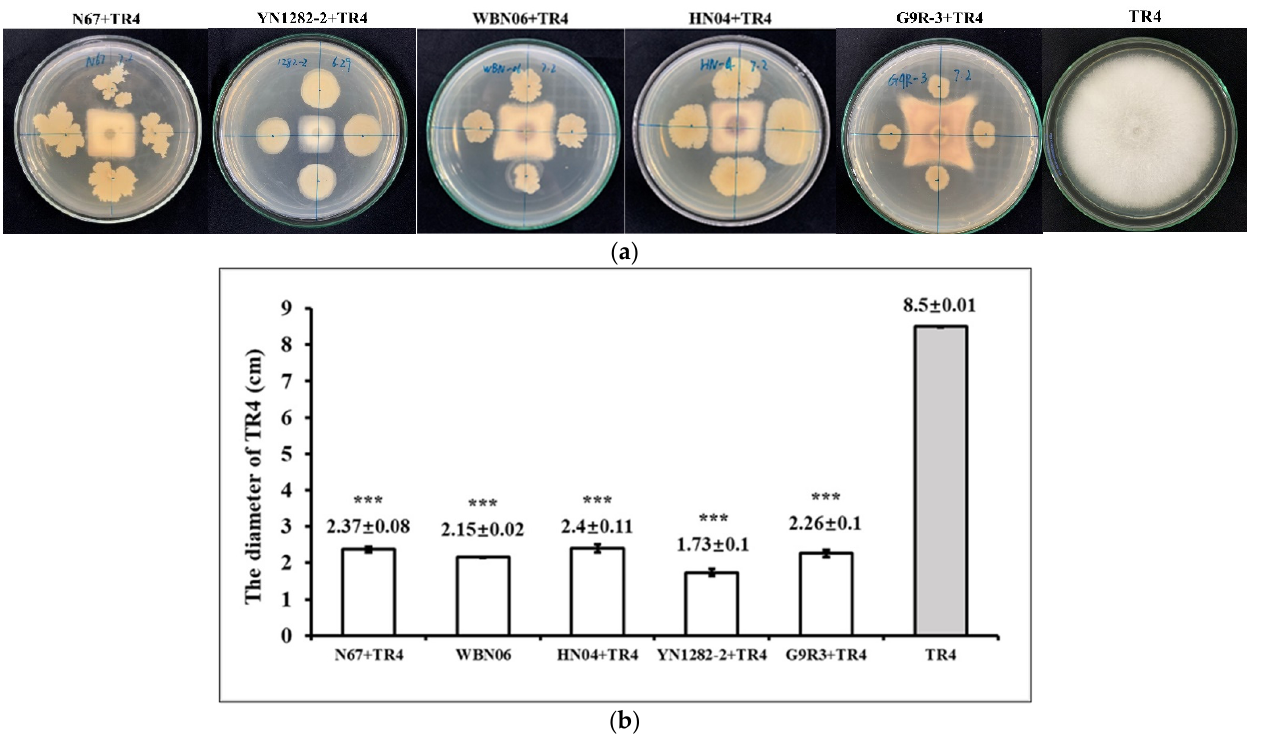
Figure 2. Effectiveness of five biocontrol Bacillus strains N67, WBN06, HN04, YN1282-2 and G9R-3 on TR4. ( a ) The dual-culture test of N67, YN1282-2, WBN06, HN04, G9R-3 and TR4 for 7 days; ( b ) the inhibition effect of N67, YN1282-2, WBN06, HN04, G9R-3 on TR4 at 7 days. The asterisk represents a significant difference in TR4 colonial diameter between single- and dual-cultures with biocontrol Bacillus strains (Student’s T -test: p < 0.001 “***”).